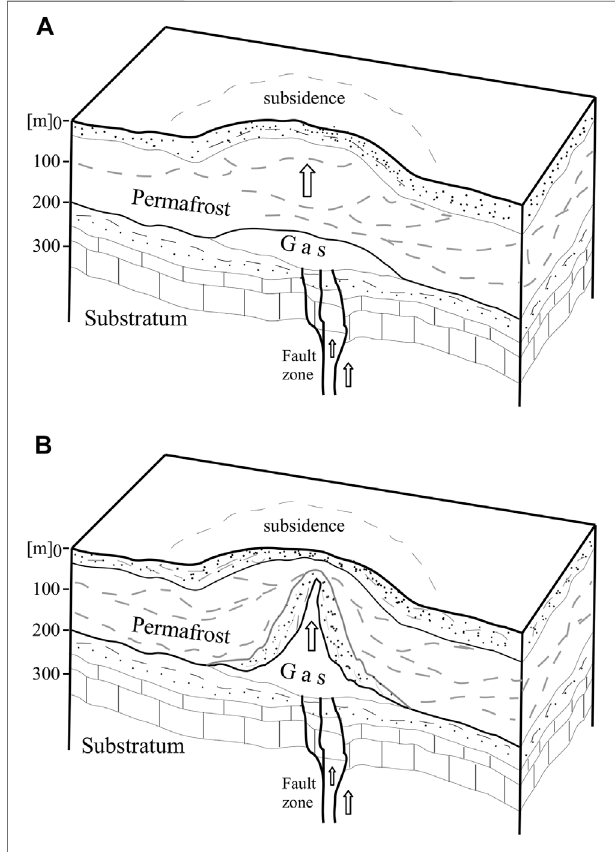
FIGURE 14 | 3D scheme representing pre-stages of possible outburst events due to ancient deep origin natural gas. Scheme (A) shows gas accumulation below the impermeable permafrost layer. The overpressure gas causes uplift at surface and triggers localized observed area of subsidence. Scheme (B) presents pre-outburst evolved stage, where deep gas causes further thermal and mechanical degradation of permafrost layer.